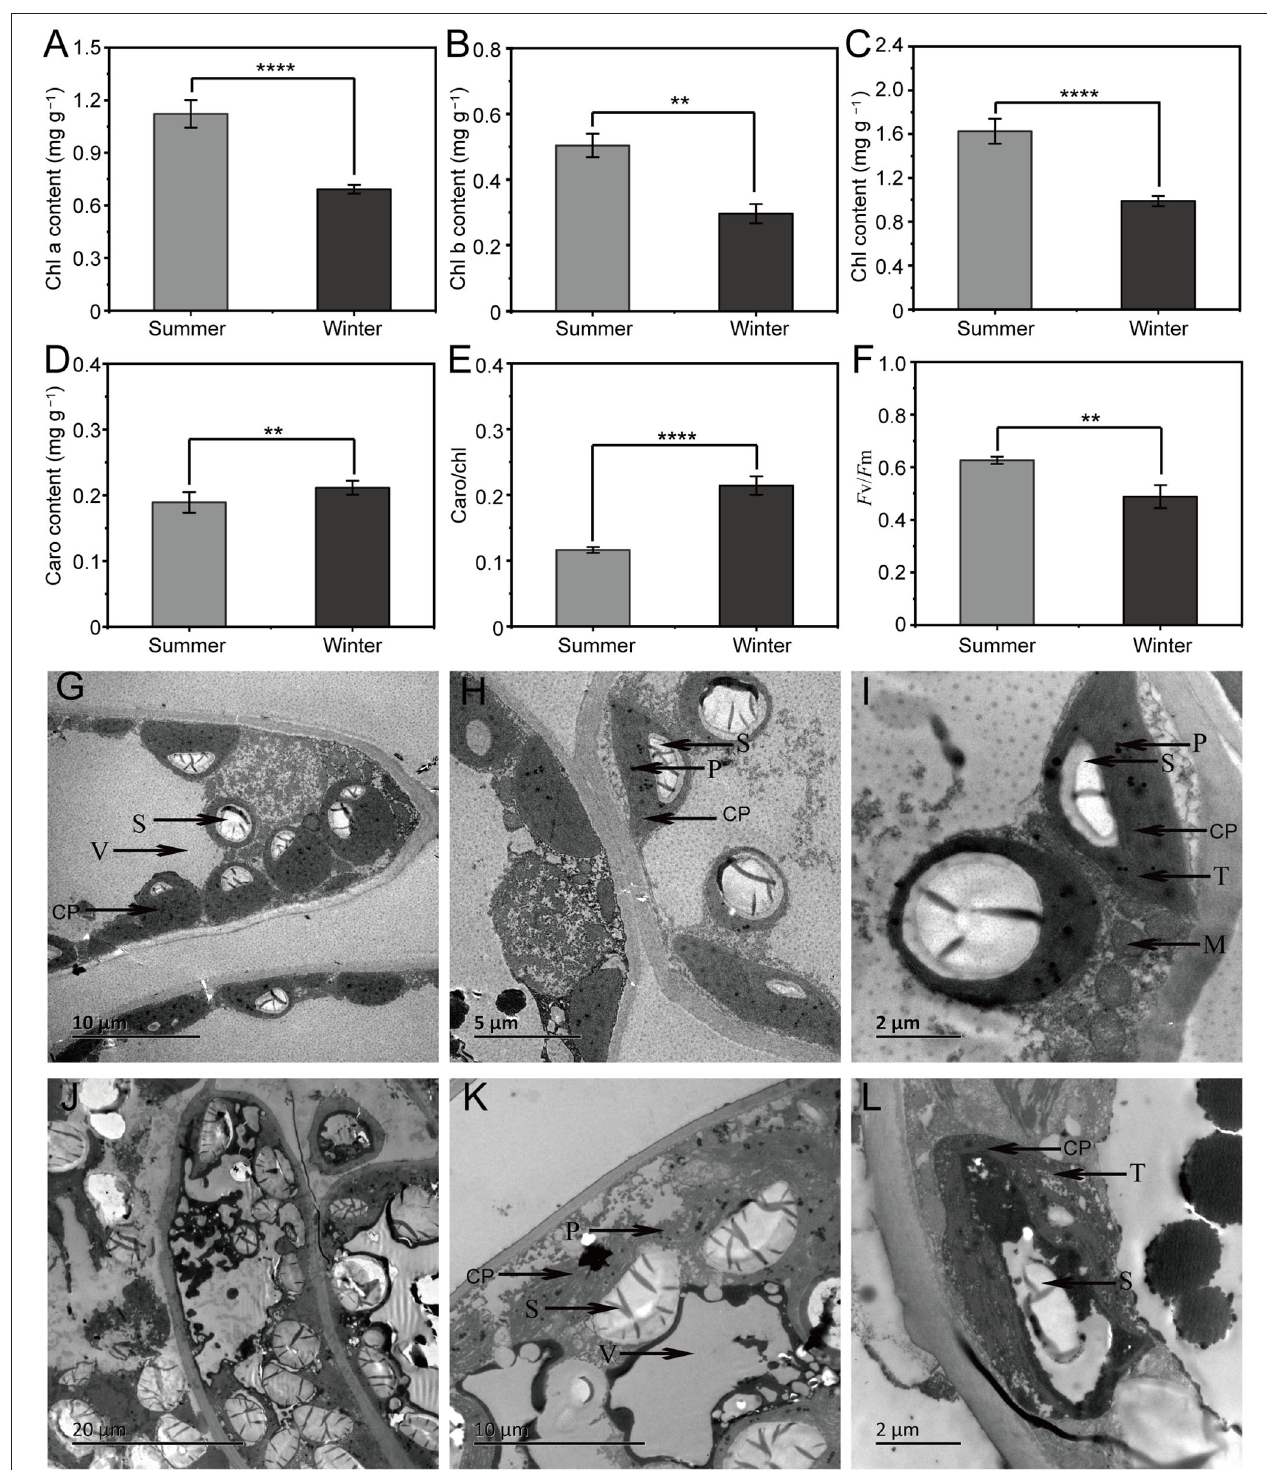
FIGURE 1 | Physiological indices and needle ultrastructure associated with seasonal changes in Cryptomeria fortunei needles. (A) Chlorophyll (chl) a content; (B) chl b content; (C) chl contents; (D) carotenoid content; (E) carotenoid/chl; and (F) F v / F m . The average ± standard deviation is displayed, n = 6. Student’s t- test was adopted to define the statistical significance of the difference, **, p < 0.01 and ****, p < 0.0001. Representative image of the needle ultrastructure of summer (G–I) and winter (J–L) C. fortunei needles. Bars = 20, 10, 5 or 2 µ m. CP, chloroplast; CW, cell wall; V, vacuole; S, starch granule; M, mitochondria; T, thylakoids; and P,